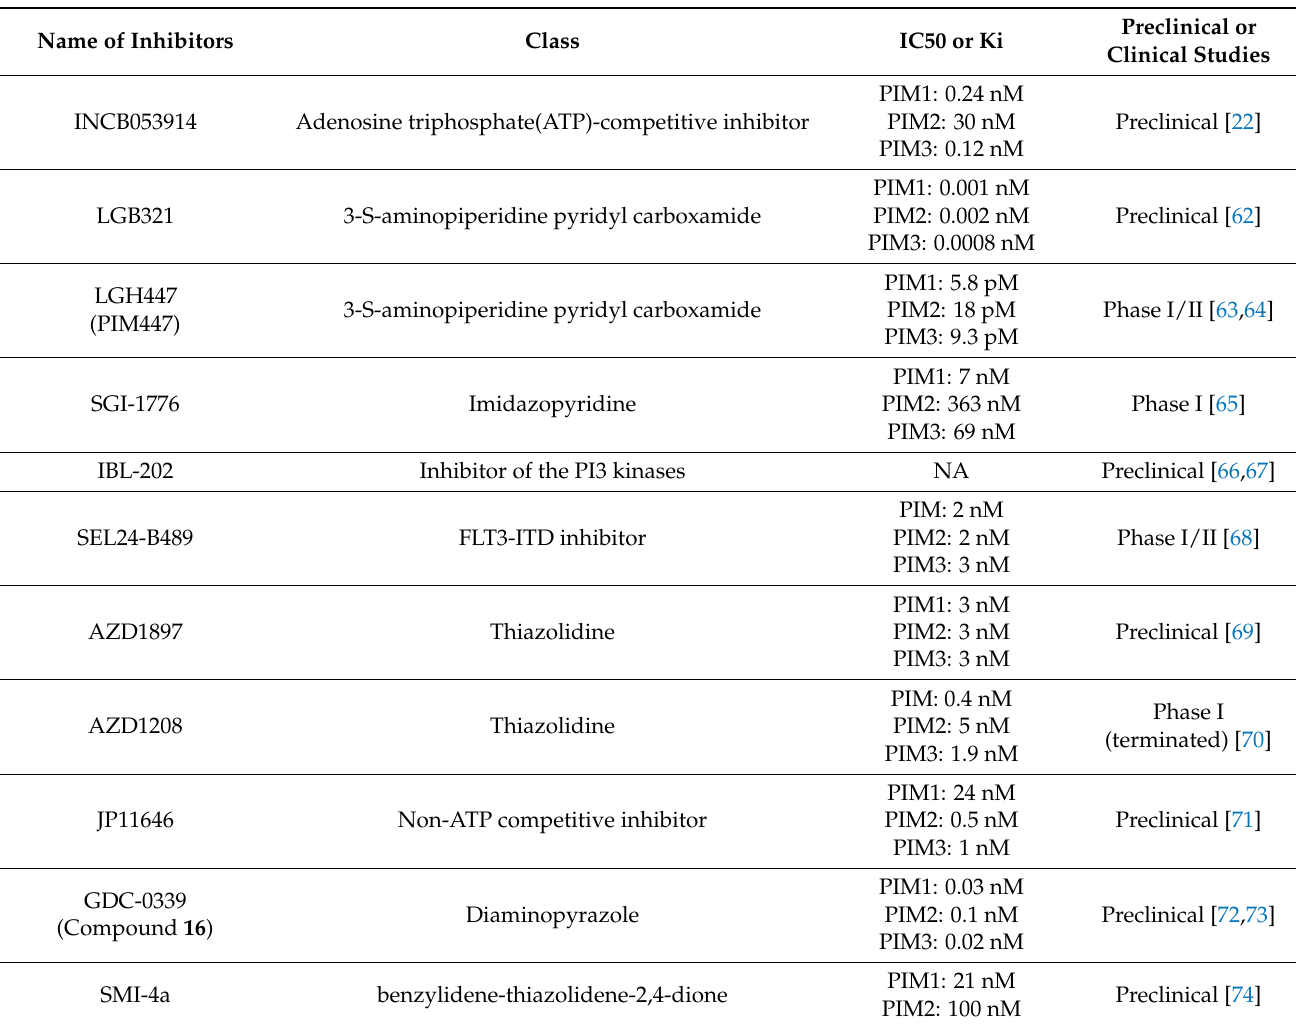
Table 1. PIM kinase